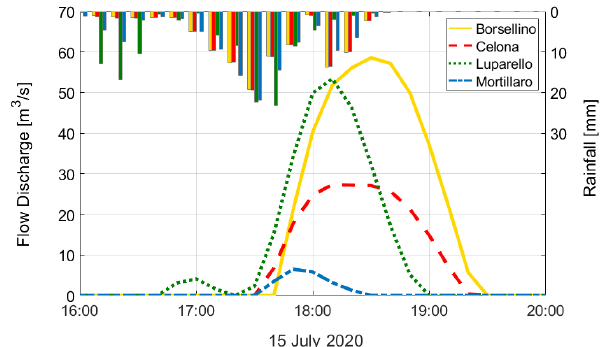
Figure 9. Flow discharge obtained from the hydrological simula- tions in TOPDM. The bars in the upper part of the figure indicate the IDW interpolated precipitation over the four